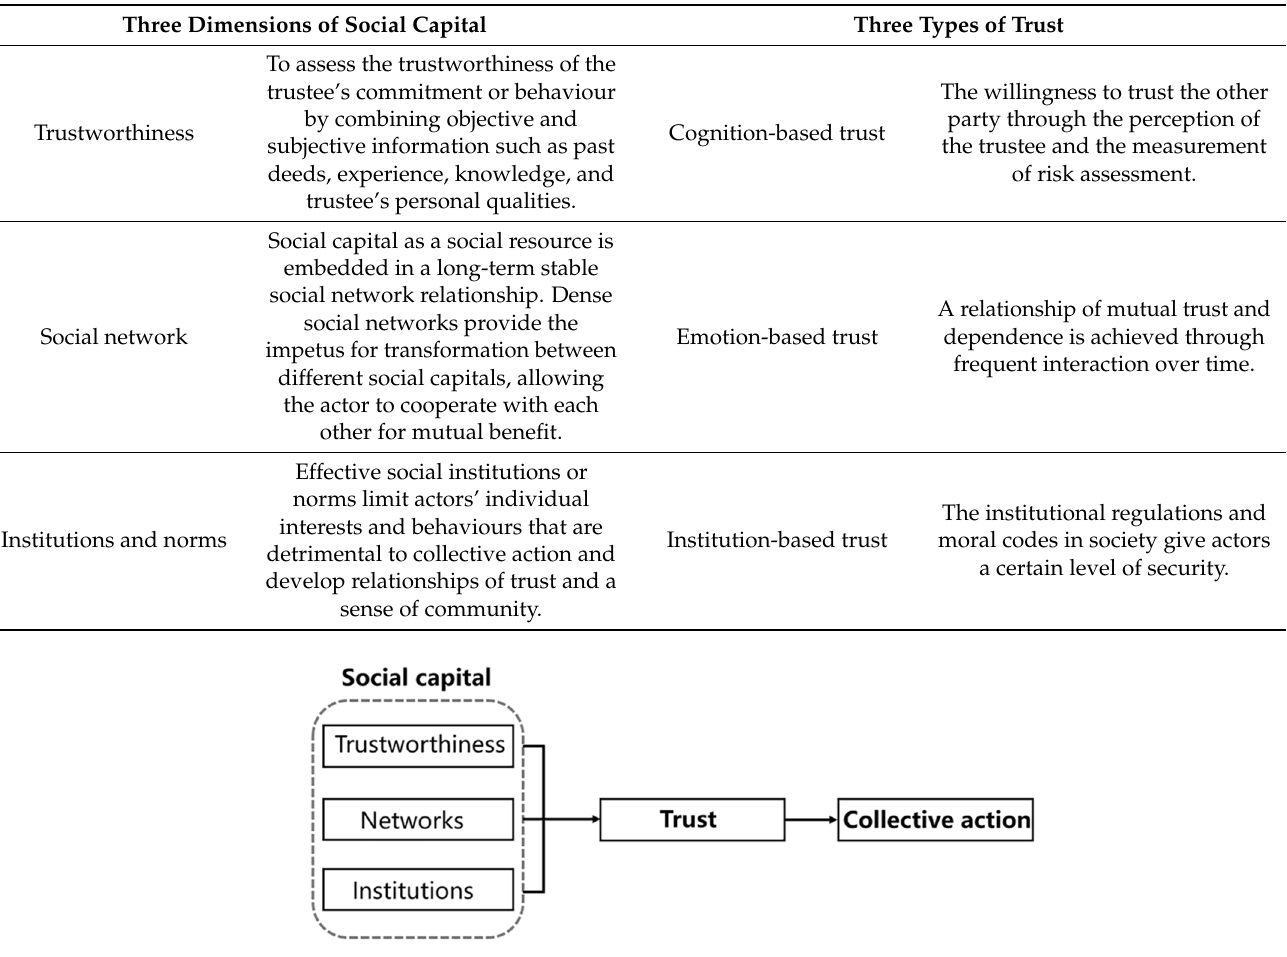
Figure 4. The framework of second-generation theories of collective action (Reprinted with permis- sion from Ref. [44], 2003, Ostrom and Ahn).